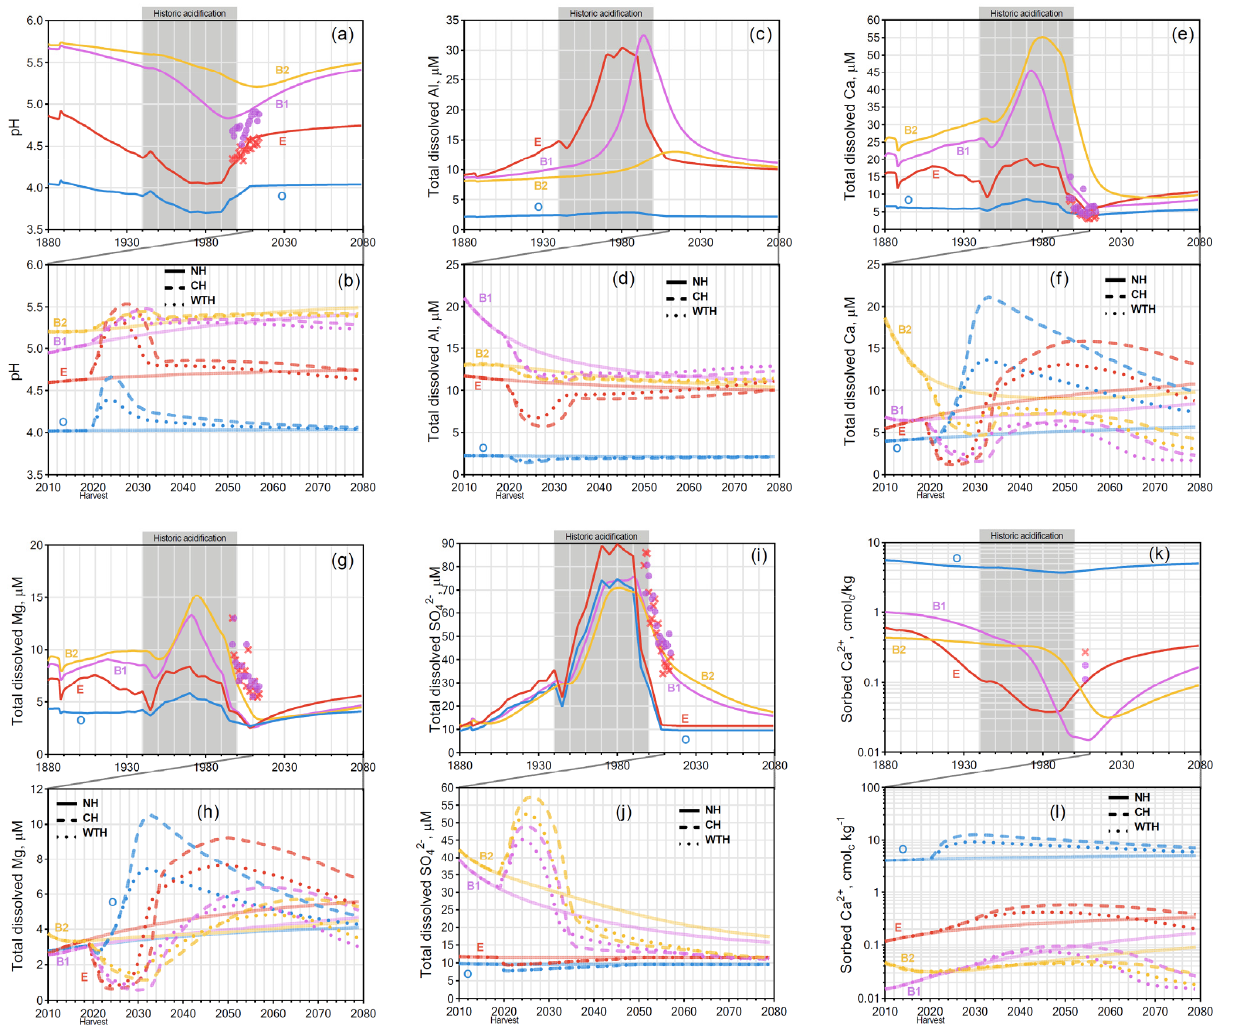
− (i, j) ; and sorbed 4